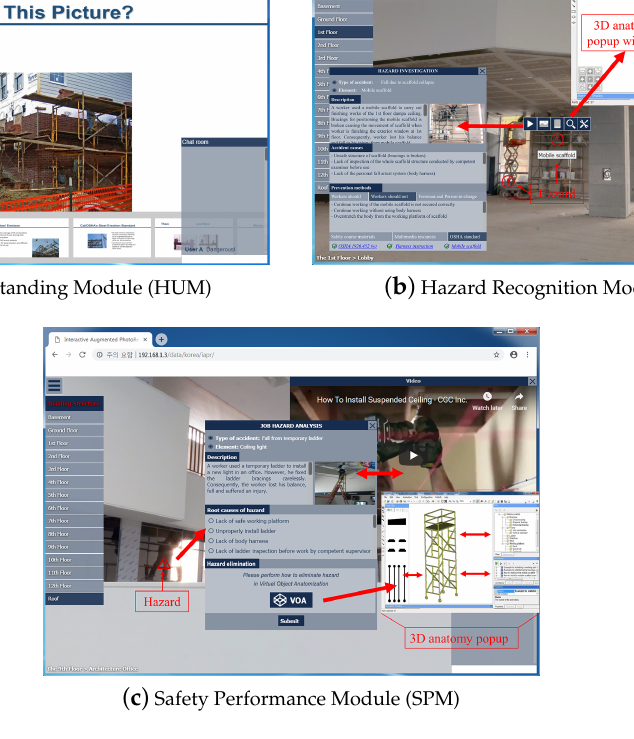
Figure 2. The Interactive Augmented Photoreality platform (iAPR) prototype